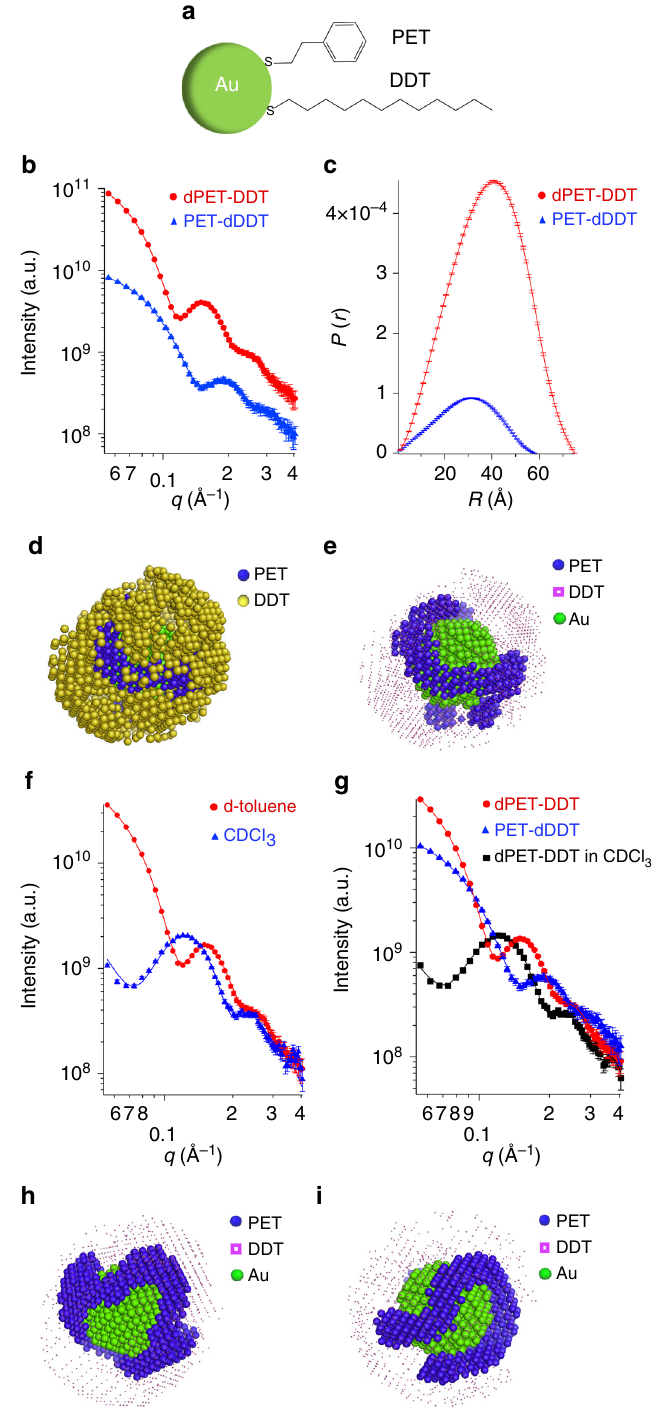
Fig. 1 SANS data and 3D models of dPET-DDT and PET-dDDT nanoparticles. a Structure of PET and DDT molecules. b SANS data (dots) and fi ts (full lines) of dPET-DDT (red) and PET-dDDT (blue) nanoparticles. The fi ts are from MONSA fi tting and correspond to the theoretical scattering curves from the model. The fi nal χ 2 value of the model fi tting is 0.79, indicating the good quality of the fi ts. c Pair distance distribution function P ( r ) of dPET-DDT (red) and PET-dDDT (blue) calculated from SANS data. d 3D low-resolution model built by fi tting the two SANS data. All three phases, i.e., DDT (yellow), PET (blue), and gold (green), are shown. e Same model highlighting shorter ligands (PET) for clarity. DDT phase is marked with small pink dots. f SANS data and fi ts and from measurements with two different solvent contrasts. Data are marked in red and blue for measurements in deuterated toluene and chloroform, respectively. g SANS data and fi ts when combining three different contrasts. The resulted 3D models for the two- ( h ) and three-contrast fi tting ( i ). The error bars in the SANS data represent standard deviations of neutron counts and are explained in detail in Method